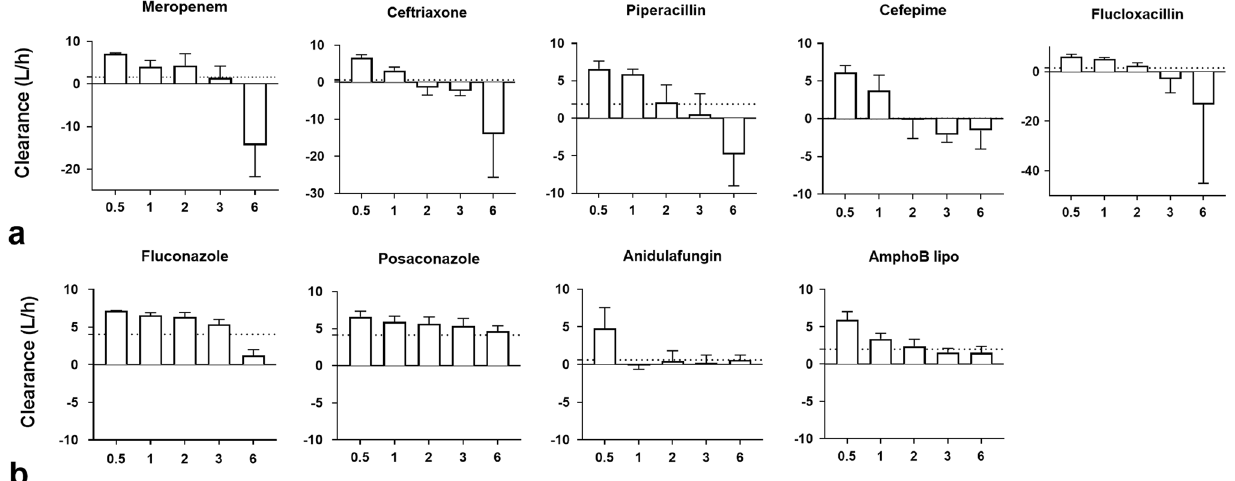
Figure 4. Kinetics of adsorber clearance of beta-lactams ( a ) and antifungals ( b ). Bars represent instantaneous clearance at the different study time points: 30 min (0.5 h), 1, 2 and 3 h after therapy initiation as well as the last measure obtained (6 h). Dotted lines represent total clearance (also represented in Fig. 2). Reported values are mean and standard deviation. AmphoB lipo: liposomal amphotericin B.